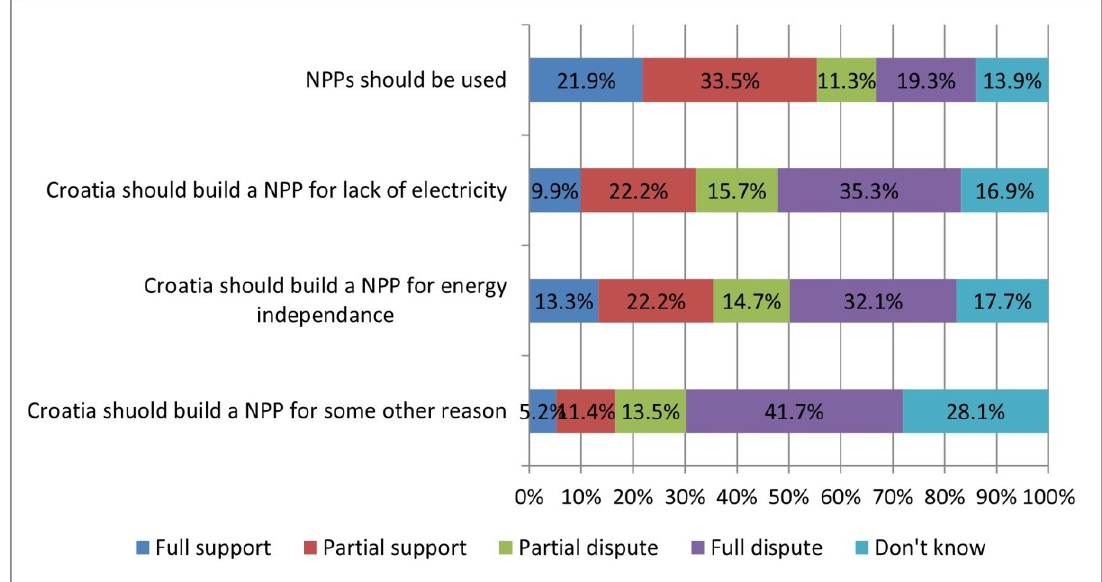
Figure 7. Should NPPs be used and should Croatia build one?